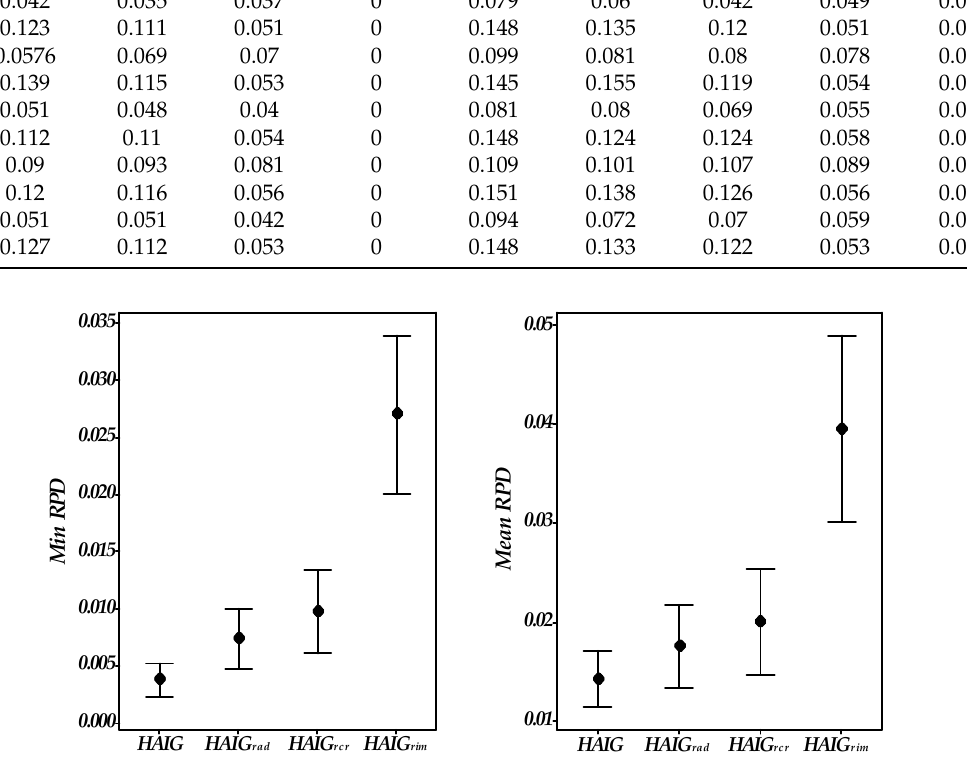
Figure 7. Comparisons of HAIG